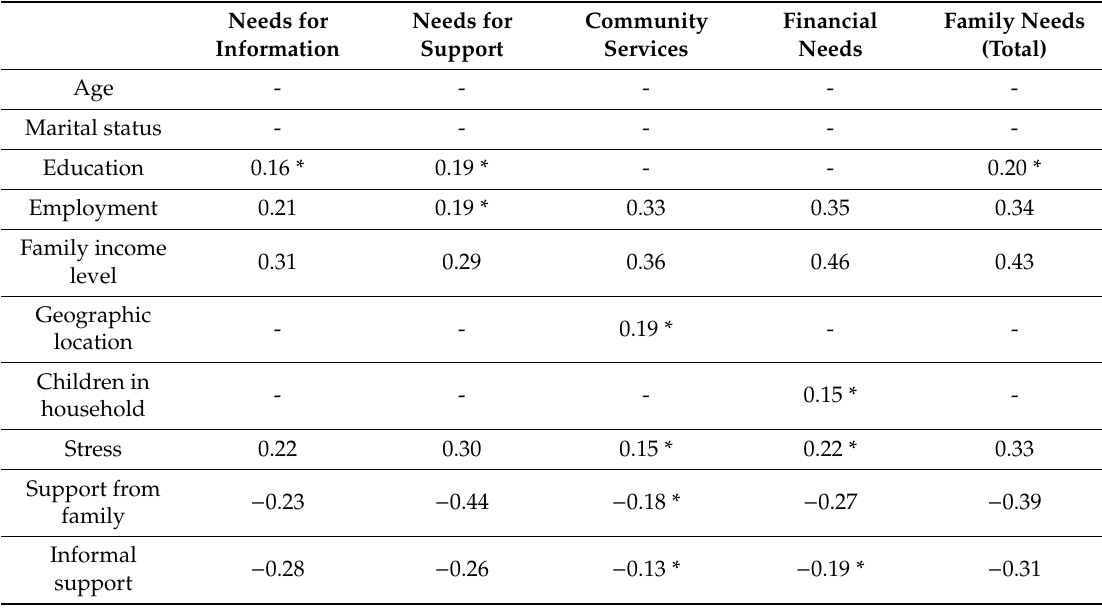
Table 9. Statistically significant correlations between family needs and family characteristics.